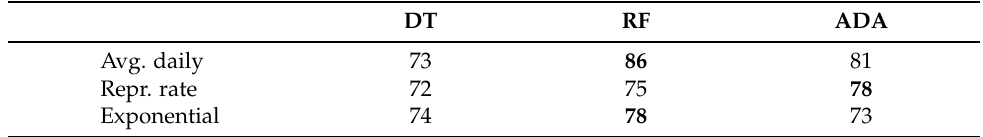
Table 12. The accuracy (%) achieved for different ML algorithms with hyper-parameter tuning and features selected by the Wrapper procedure. The experiment was repeated for each class, and the highest accuracy is shown in bold. Baseline DT RF ADA Avg. daily 51 86 80 83 Repr. rate 61 71 70 66 Exponential 68 66 70 70 Table 13. The Area Under Curve (AUC) score (%) achieved for different ML algorithms with hyper- parameter tuning and features selected by the Wrapper procedure. The experiment was repeated for each class, and the highest accuracy is shown in bold. DT RF ADA Avg. daily 73 86 81 Repr. rate 72 75 78 Exponential 74 78